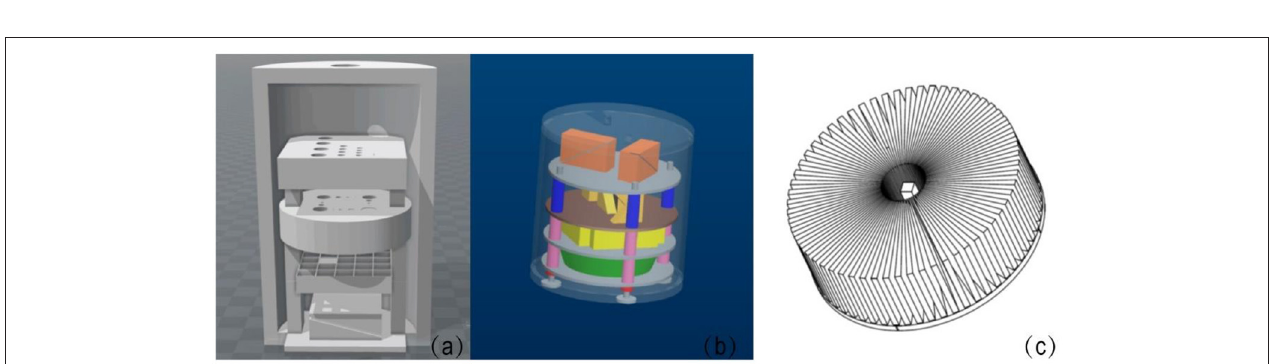
FIGURE 1 | The test process of the material samples. (a) Placing material cubes (pointed by the red arrow) in the NMR for porosity test; (b,c) locking the samples (pointed by the red arrow) in the VST tester for deformation temperature assessment.